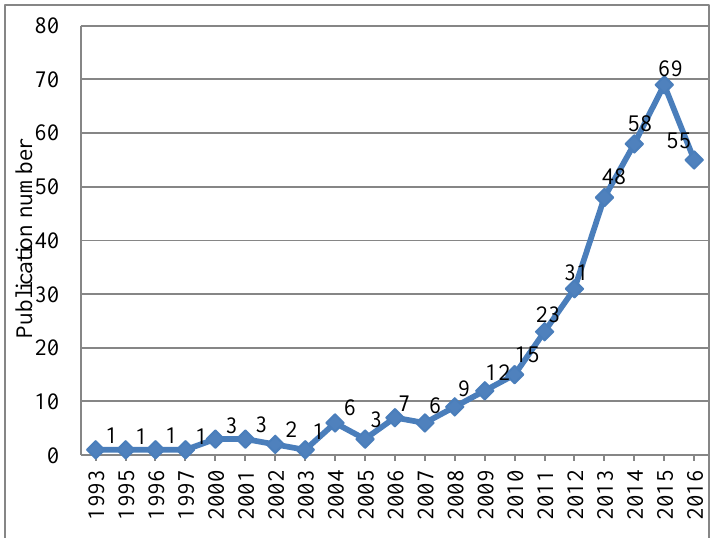
Figure 2. Publications records related to urban resilience in the WOS core collection, published from January 1993 and December 2016.